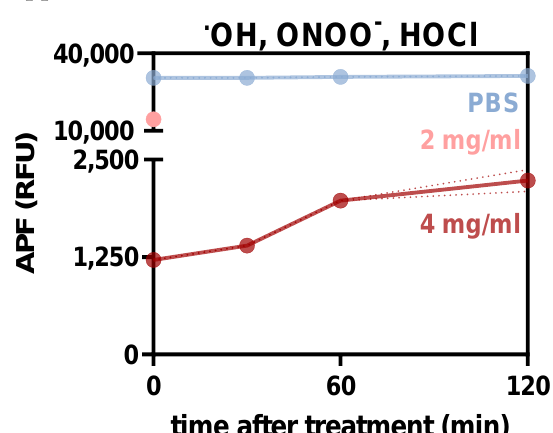
Figure A1. Relative assessment of short-lived species in stiff hydrogels over time. Relative aminophenyl fluoresceine (APF) fluorescence intensity (RFU) in PBS, 2 mg/mL and 4 mg/mL collagen 0, 30, 60 and 120 min after plasma treatment. Graph shows mean ± standard error of the mean (SEM). RFU = relative fluorescence units.